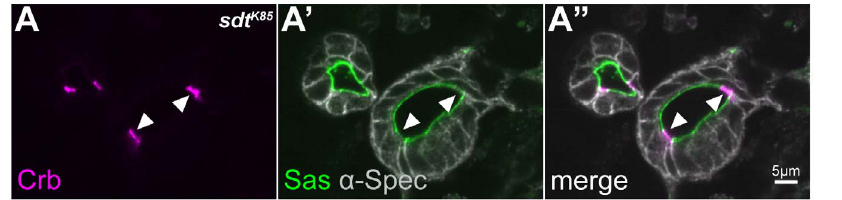
Figure 3. Apical localisation of Crb in BCs is independent of its known interaction partner Sdt. Confocal microscopy images of a cross section through the large intestine of a stage 15 homozygous sdt K85 mutant embryo stained with anti-Crb (magenta), anti- a -Spectrin (grey) and anti- Sas (green). Crb is upregulated and apically localised in the BCs (white arrowheads), but is not detectable in the SAR of the PCs (A, A 0 ). Sas, an apical marker of the monolayered epithelial tube, is reduced in the BCs (A 9 , A 0